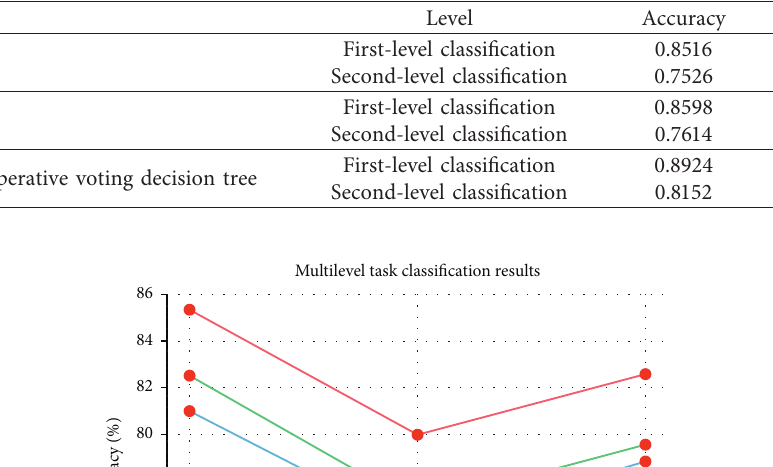
Table 7: Experimental results of ensemble learning model classification.